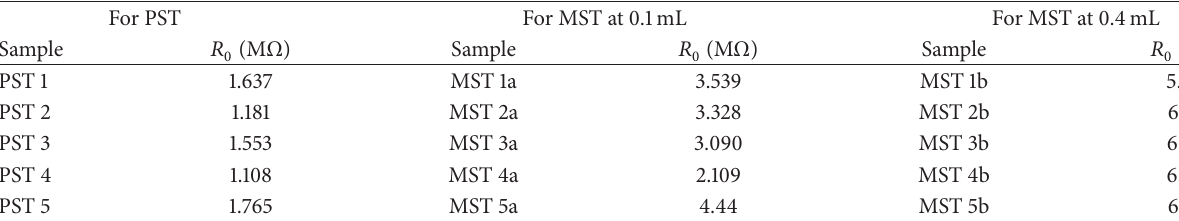
Table 1: Original resistance ( 𝑅 0 ) for the layers used in each test before any THF pulse.